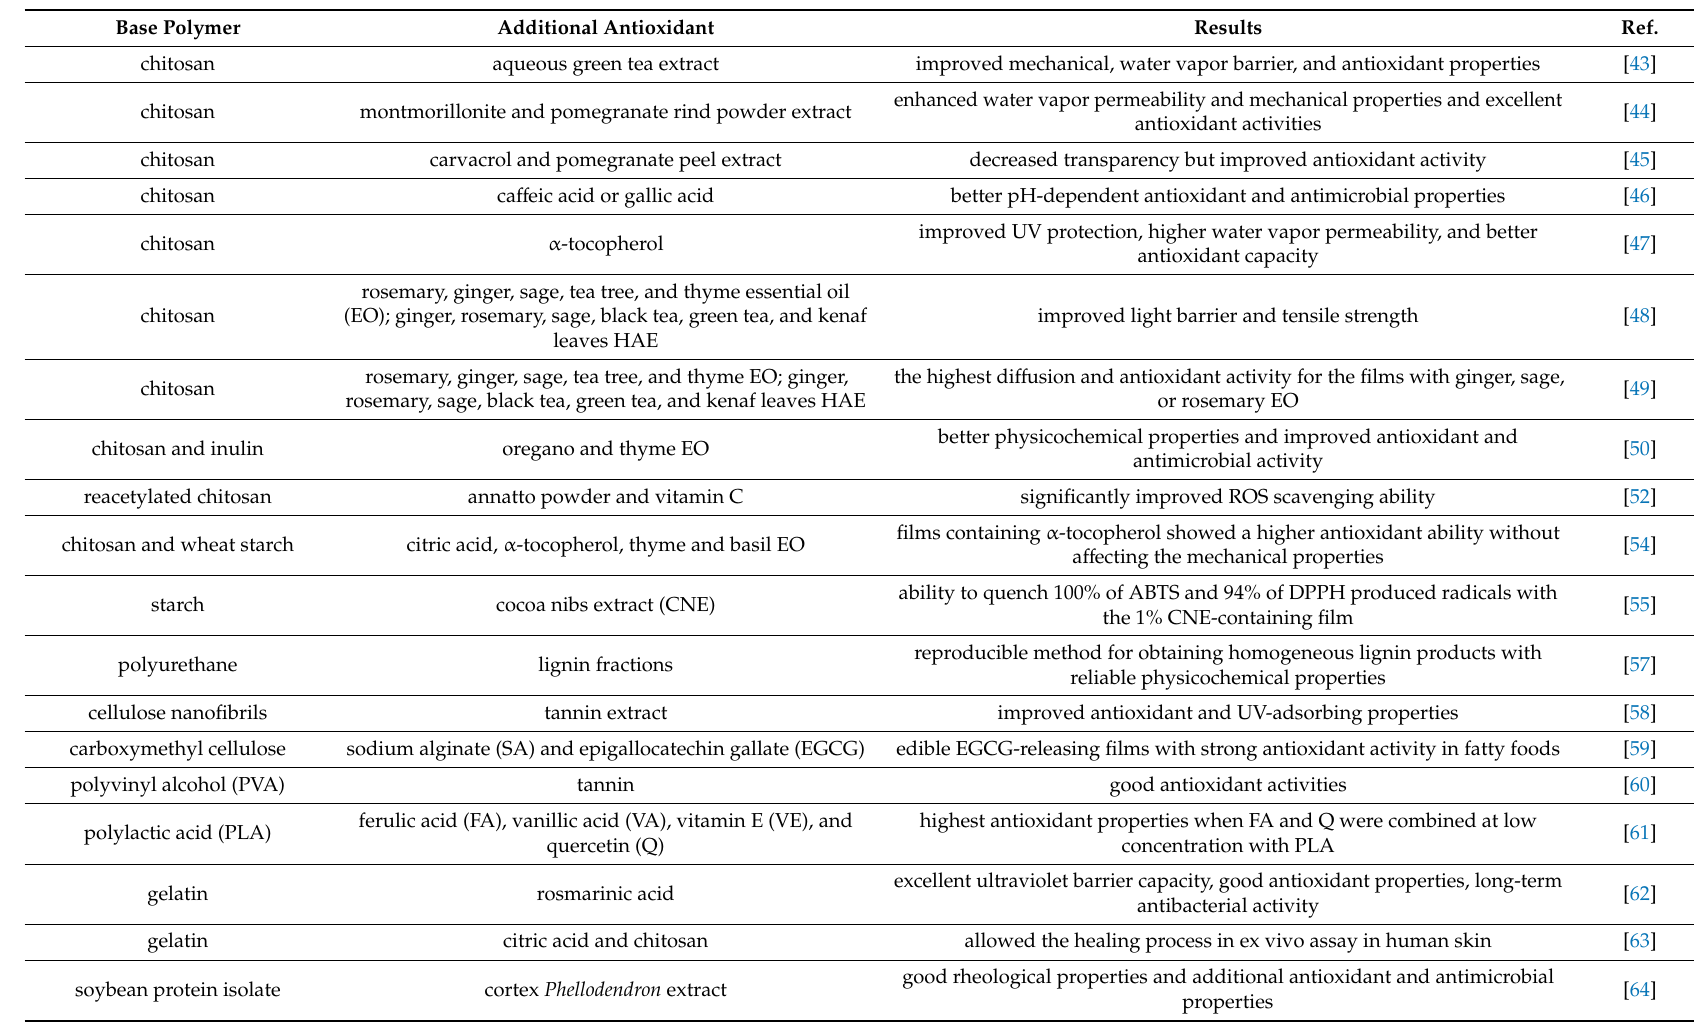
Table 2. Summary of the antioxidant polymeric films and their e ff